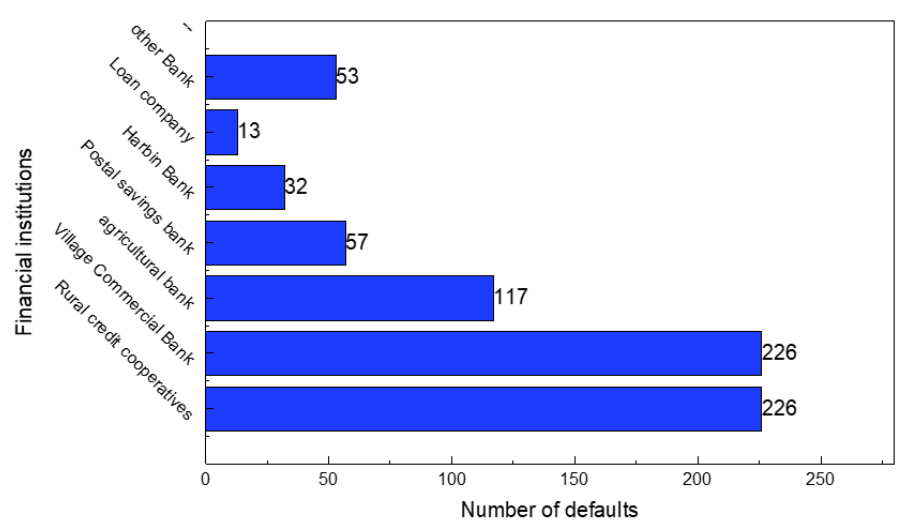
Figure 4. Financial institutions and the number of farmland mortgage default cases during 2014–2020.